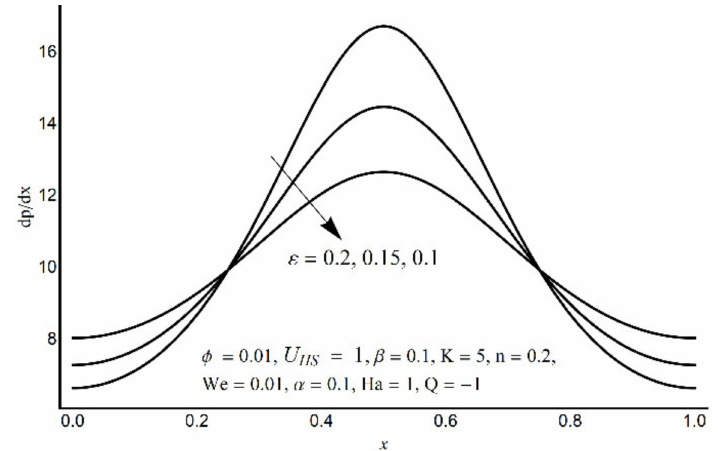
Figure 6. Pressure gradient at varying ε .